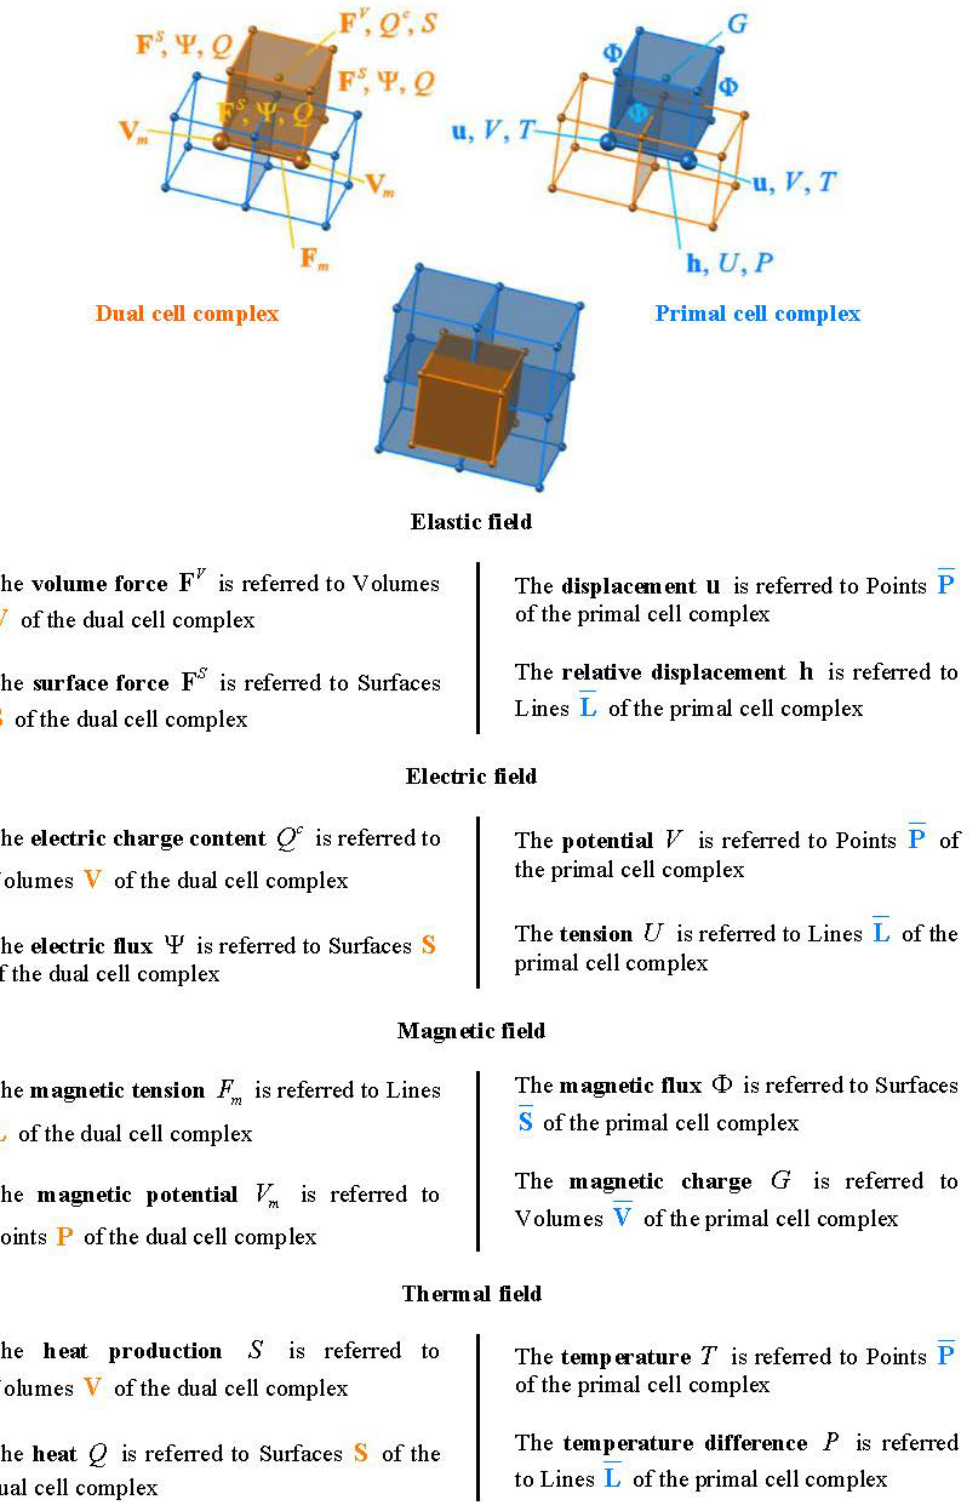
Figure 3: Association between global variables and space elements of the primal and dual cell complexes, in different physical